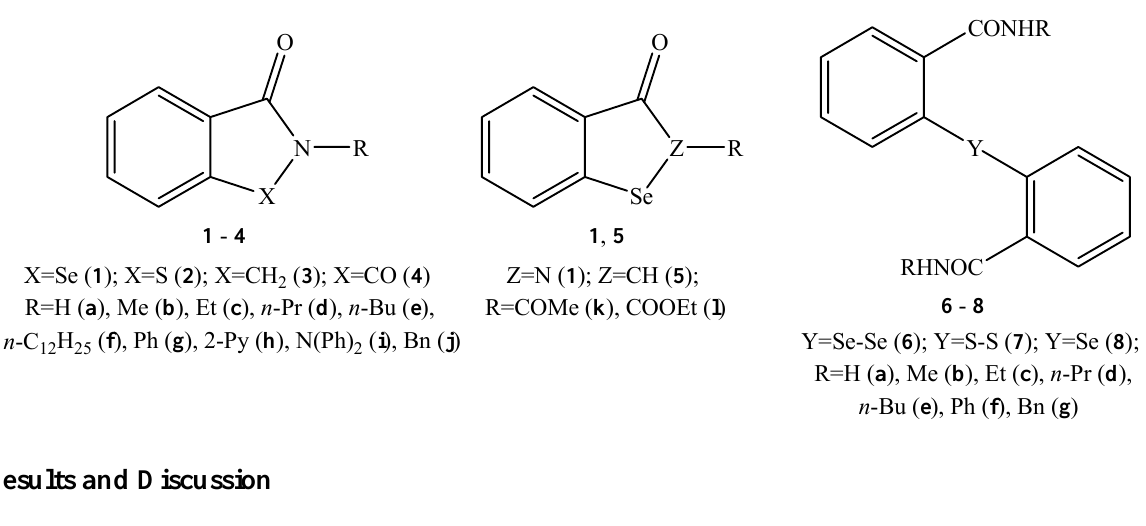
Figure 1. General formulas of tested compounds 1 – 8